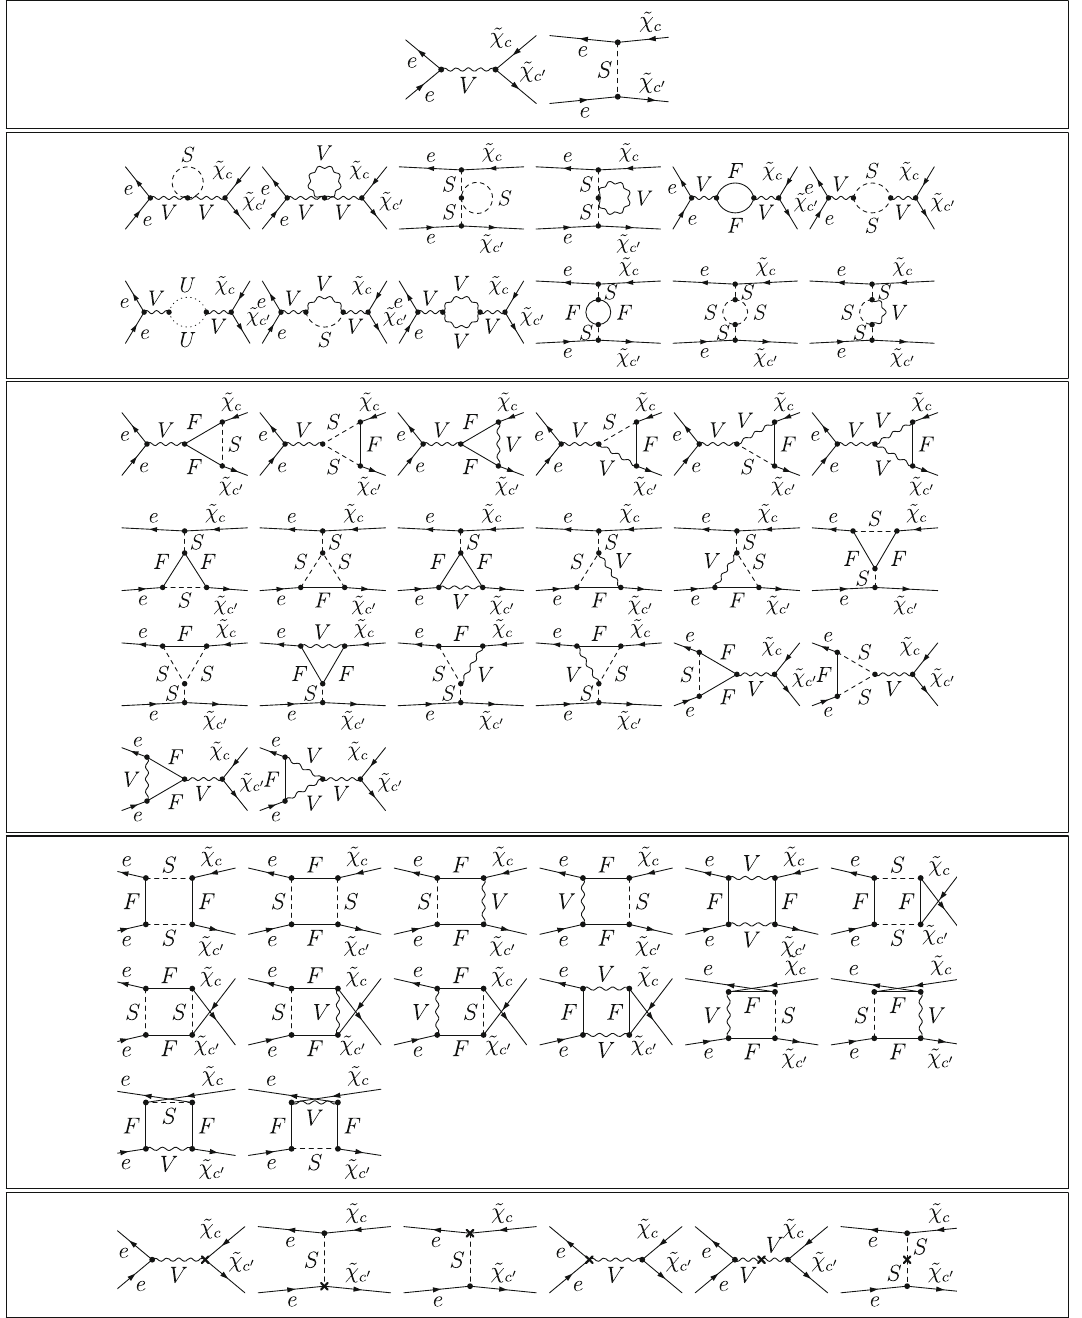
Fig. 1 Generic tree, self-energy, vertex, box, and counterterm dia- Higgs/Goldstone boson; V can be a γ , Z or W ± . It should be noted grams for the process e + e − → ˜ χ ± c ˜ χ ∓ that electron–Higgs couplings are neglected ( c , c (cid:4) = 1 , 2). F can be c (cid:4) a SM fermion, chargino or neutralino; S can be a sfermion or a